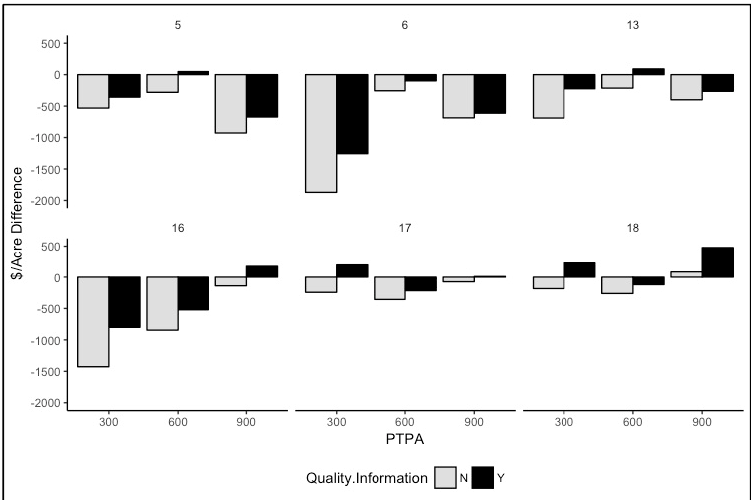
Figure 8. Difference in operational management and intensive management value standing timber (U.S. $/hectare) at age 30 for each installation (installation number indicated above bars). Intensive management dollar value subtracted from the operational value for each planting density. Quality information includes the use of the TQI scores and product-defining defect heights. Negative values indicate a per hectare value greater for the intensive management regime than the complimentary operational management regime for the given planting density. “Y” = Yes, “N” = No.